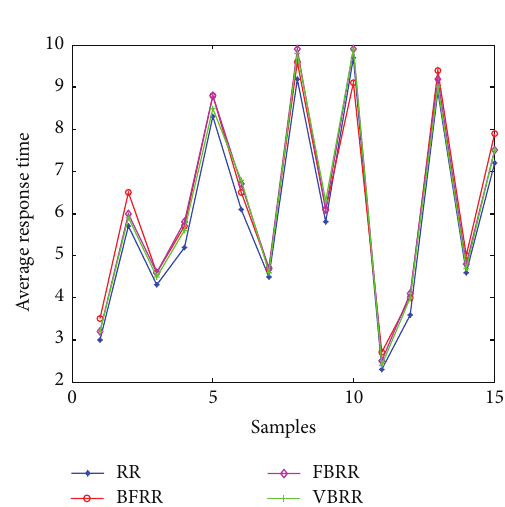
Figure 12: Average response time.